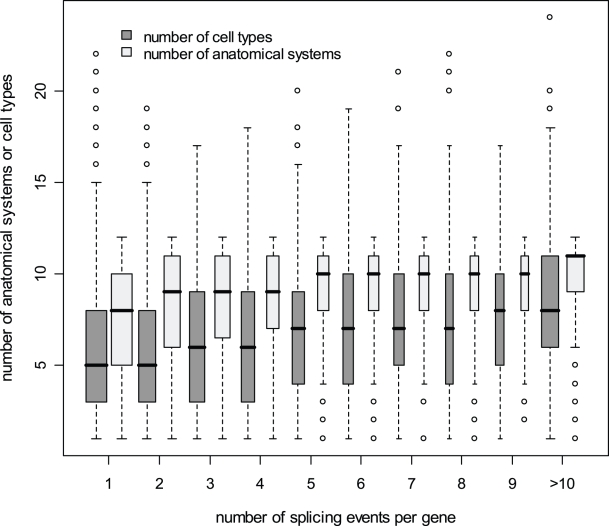
Box plot of the pattern of gene expression as a function of the number of splicing events for PS genes in humans.The number of anatomical systems is shown in light grey and the number of cell types is indicated in dark grey. The width of the boxes is proportional to the square-root of the number of genes in each group. The correlation between the number of splicing events and the width of the expression profile for PS genes is highly significant (anatomical systems: r = 0.224, p<0.001; cell types: r = 0.238, p<0.001).